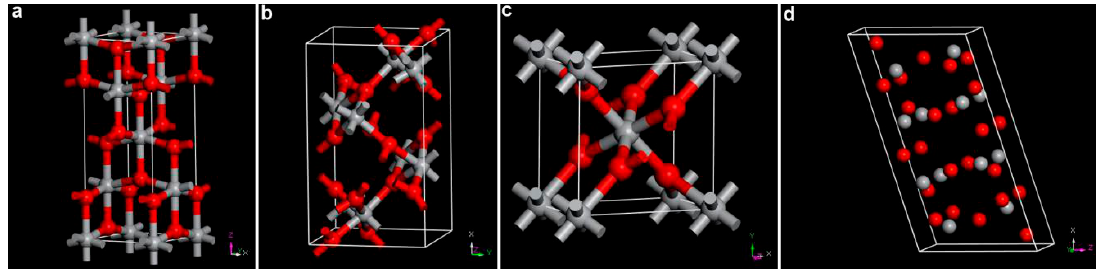
Figure 1. Crystal structures of typical TiO 2 polymorphs: ( a ) rutile; ( b ) brookite; ( c ) anatase; and ( d ) TiO 2 (B). Gray and red spheres are Ti 4+ and O 2 − ions, respectively.